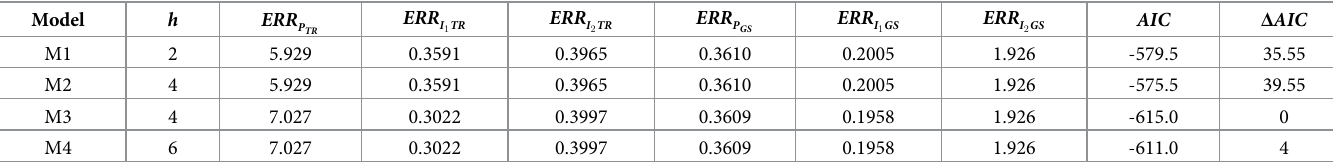
Table 7. Summary of competing models for the dual infection based on performance and level of complexity. Model complexity, h , the contribution of each variable to the error function ( ERR P , ERR and ERR ; see Eq 3), AIC and Δ AIC are reported. I 1 I 2 Model